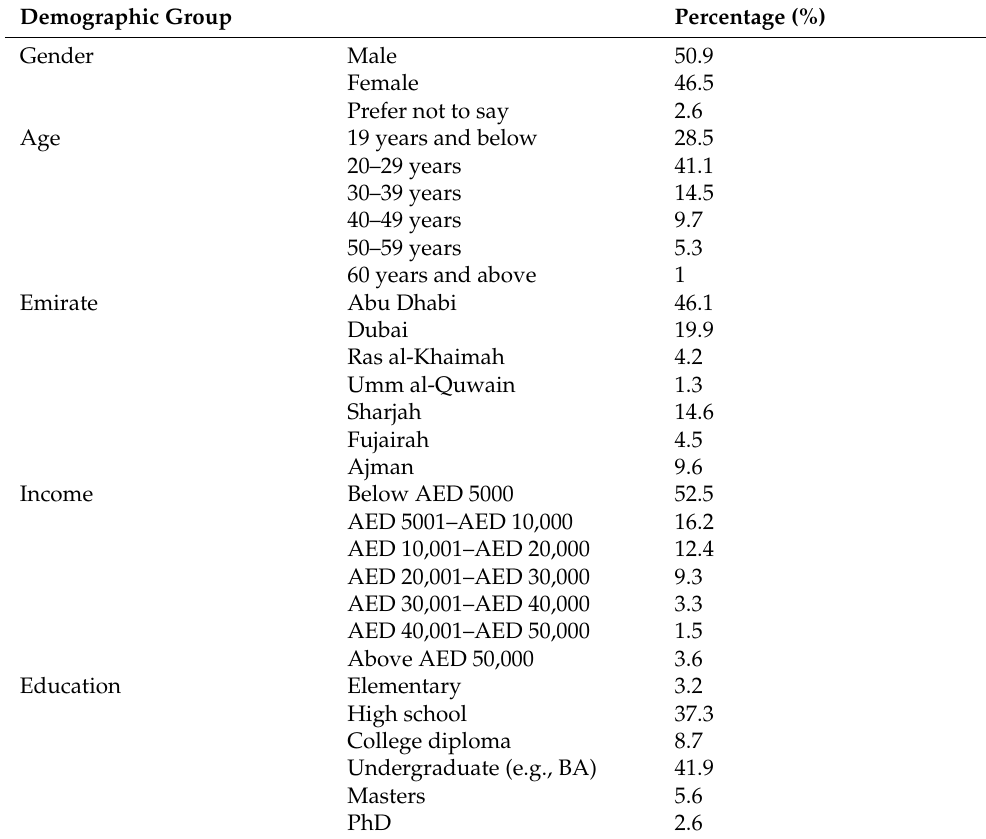
Table 1. Respondents’ demographic group characteristics ( N =